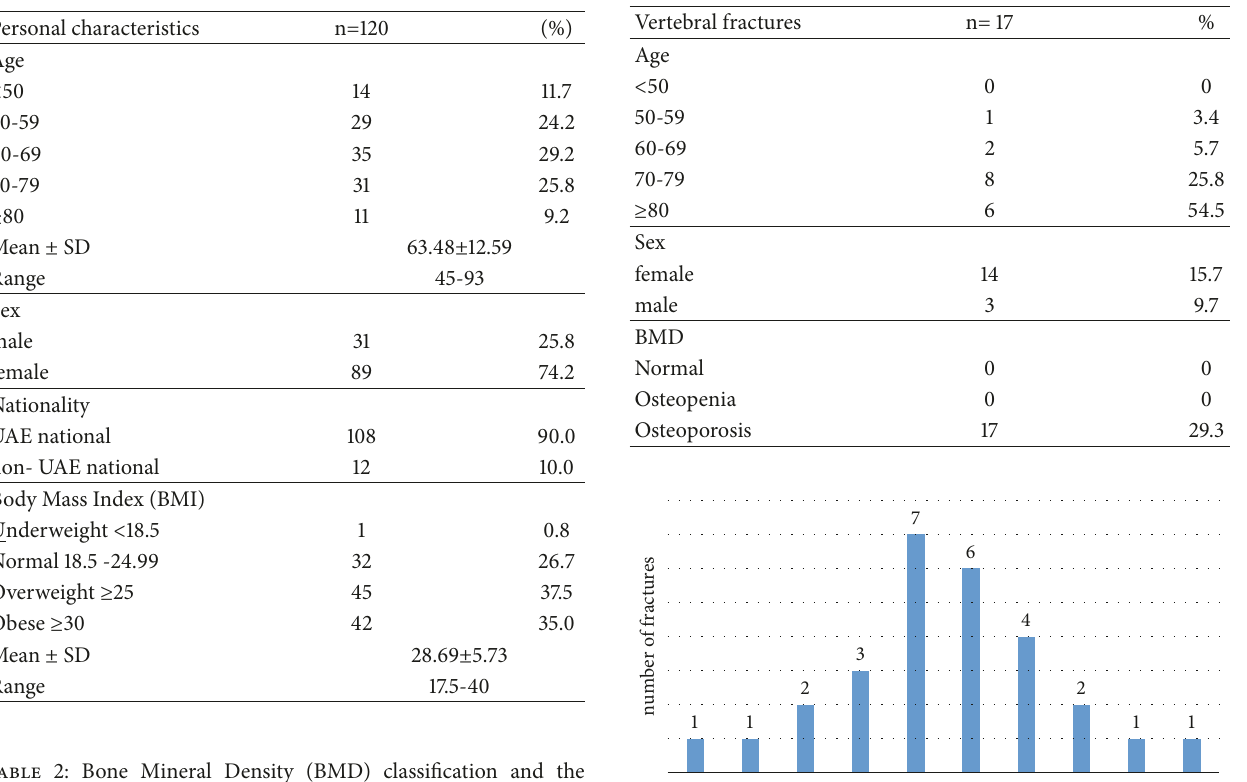
Table 1: Distribution of patients attending the osteoporosis clinic according to personal characteristics.